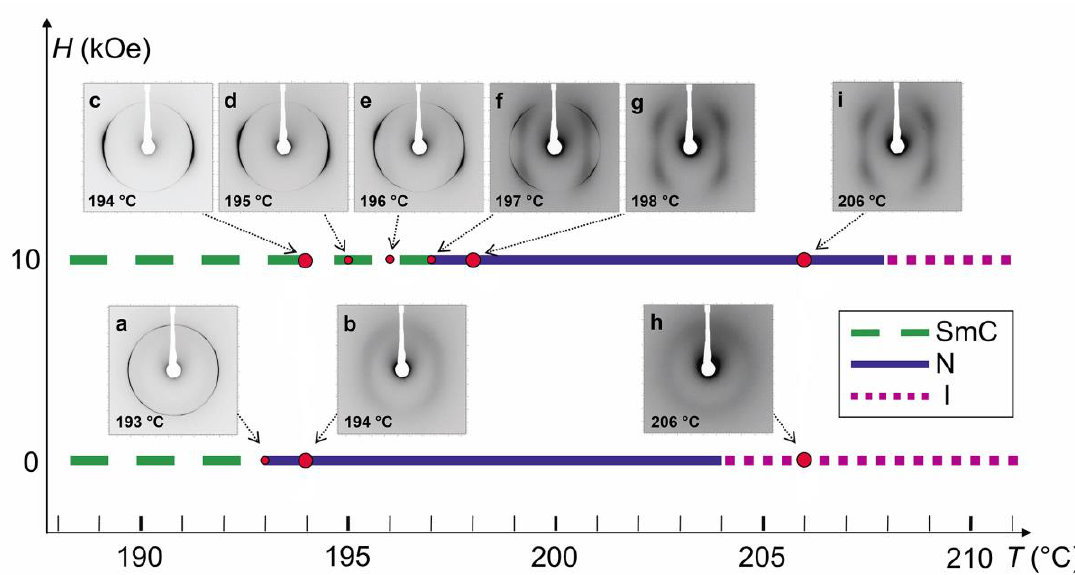
Figure 10. Phase diagrams of BCM 1b at H = 0 kOe and H = 10 kOe. The insets show the low-angle XRD patterns at selected temperatures across the diagrams. Figure adapted with permission from [43]. Copyright 2011 by the American Physical Society.